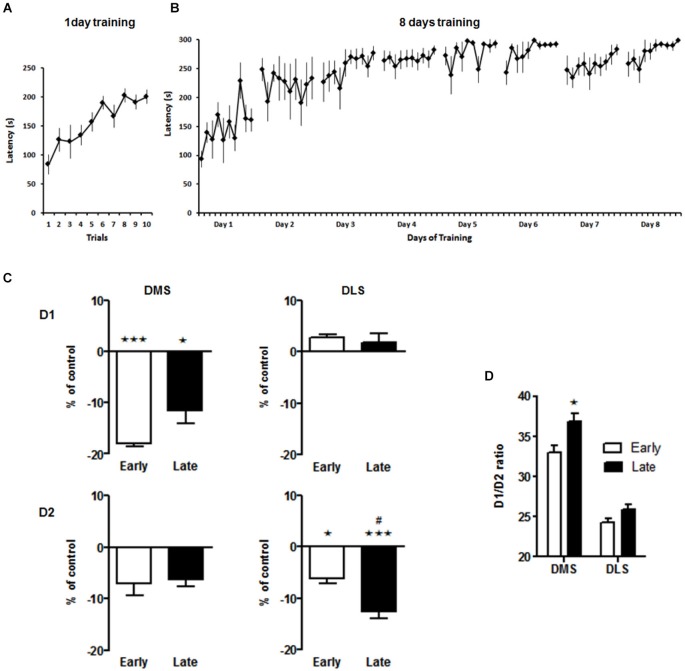
Spatiotemporal pattern of D1 and D2 binding in the dorsal striatum 1 week after the acquisition or consolidation of skill learning. Performance of the animals on the accelerating rotarod for the early (A) and late (B) experimental groups. Latency to fall off the rotarod throughout all training session is shown. (C) Ligand binding to D1 and D2 receptors in the dorsomedial (DMS) and dorsolateral (DLS) striatum. Data are presented as percentage (±SEM) of specific binding from the untreated control animals. * p < 0.05, *** p < 0.001 vs. control group. # p < 0.05 early vs. late group. (D) Ratio of D1/D2 receptors in DMS and DLS after the early and late training phase. * p < 0.05 early vs. late in DMS. For detailed statistics see text.